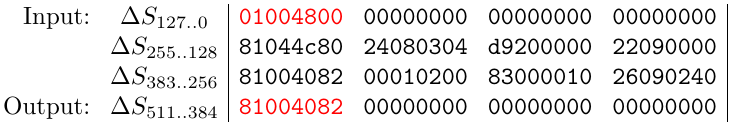
Table 4: Probability 2 − 74 Type 3 differential trail for 384 rounds found with the refined model. The differences are restricted to the 32 MSBs in the input and output. Those are stressed by red. Information of intermediate differences is provided to recover all the differential propagations in the trail.